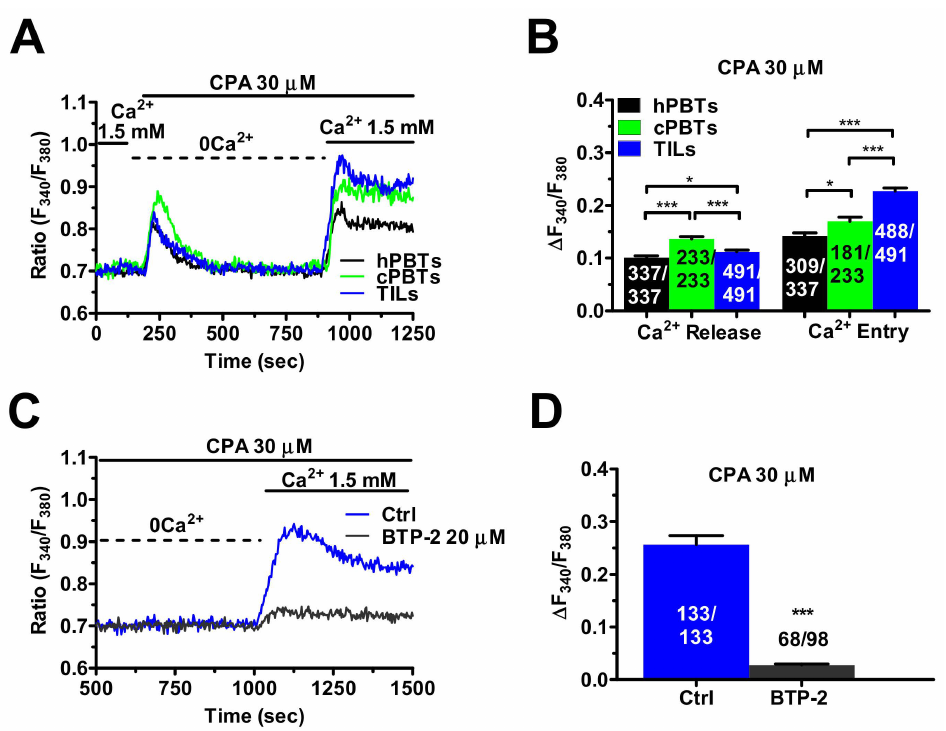
Figure 2. SOCE is enhanced in TILs. ( A ) The ER Ca 2+ pool was depleted by challenging the cells with CPA (30 µ M), a selective inhibitor of SERCA activity, in the absence of external Ca 2+ (0Ca 2+ ). Under 0Ca 2+ conditions, CPA evoked a transient increase in [Ca 2+ ] i that was due to passive ER Ca 2+ efflux through leakage channels, followed by Ca 2+ sequestration by multiple mechanisms, such as mitochondria, Na + /Ca 2+ exchanger (NCX) and plasma-membrane Ca 2+ -ATPase (PMCA) [26,37,38]. Subsequently, SOCE was evaluated by replenishing Ca 2+ to the perfusate (1.5 mM). ( B ) Mean ± SE of the amplitude of CPA-induced intracellular Ca 2+ release and CPA-induced SOCE in hPBTs, cPBTs and TILs. One-way ANOVA followed by the post hoc Bonferroni test: * p < 0.05 and *** p < 0.001. ( C ) Pre-incubating TILs with BTP-2 (20 µ m, 20 min), a selective Orai1 inhibitor, strongly reduced SOCE. BTP-2 was added in the continuous presence of extracellular Ca 2+ after the recovery to the baseline of CPA-evoked intracellular Ca 2+ mobilisation. ( D ) Mean ± SE of SOCE amplitude in the absence (Ctrl) and presence of BTP-2. Student’s t -test: *** p < 0.001. In panels ( B , D ), the numbers within or above the histogram bars indicate the number of responding cells over the total number of analysed